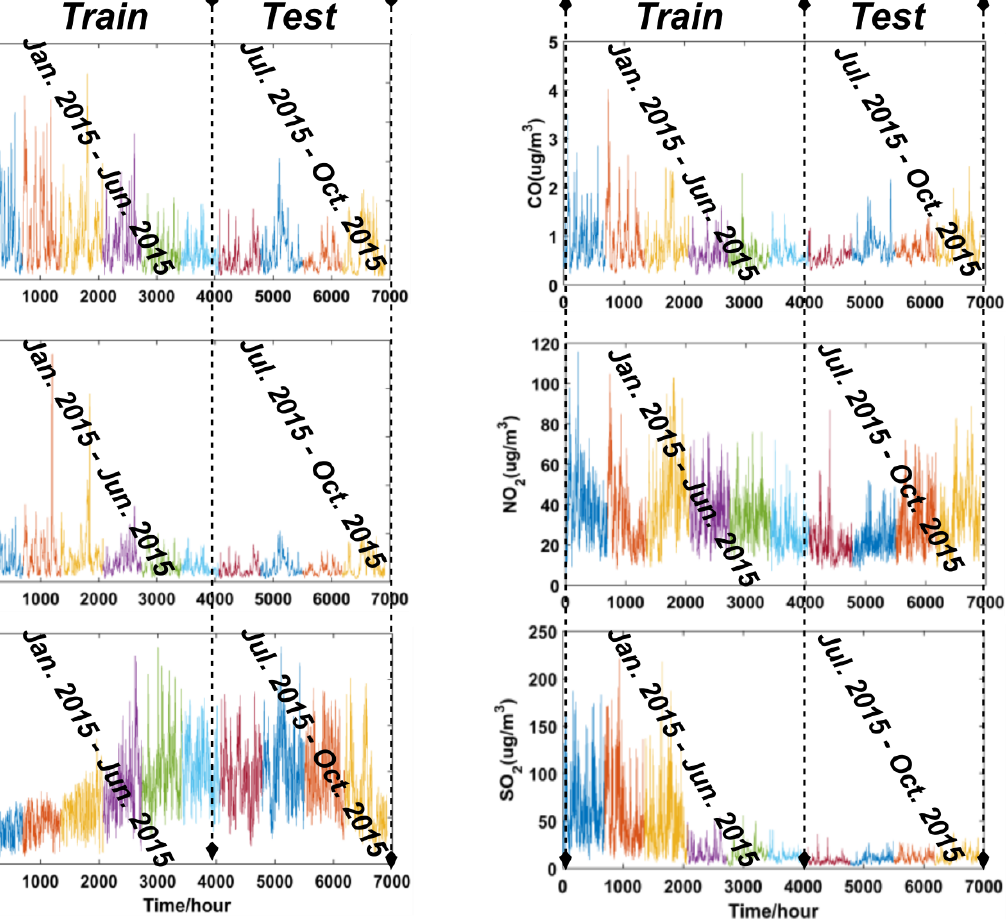
Figure 4. Training and testing subsets for the forecasting model.